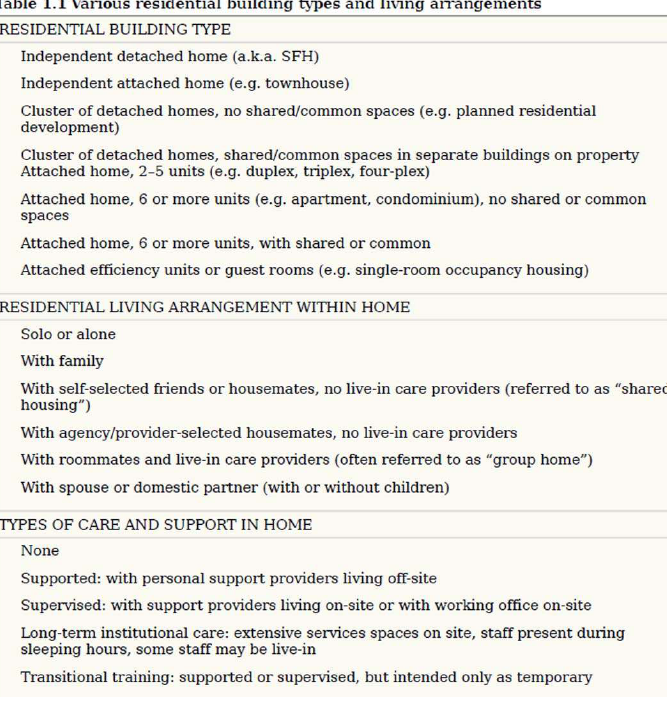
Figure 1. Various Residential Types and Living Arrangements of Individuals with ASD [14].